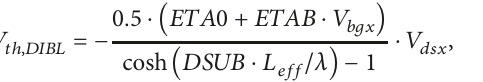
where 𝜆 is scale length factor, V surface potential, L DVT1 are parameters from device